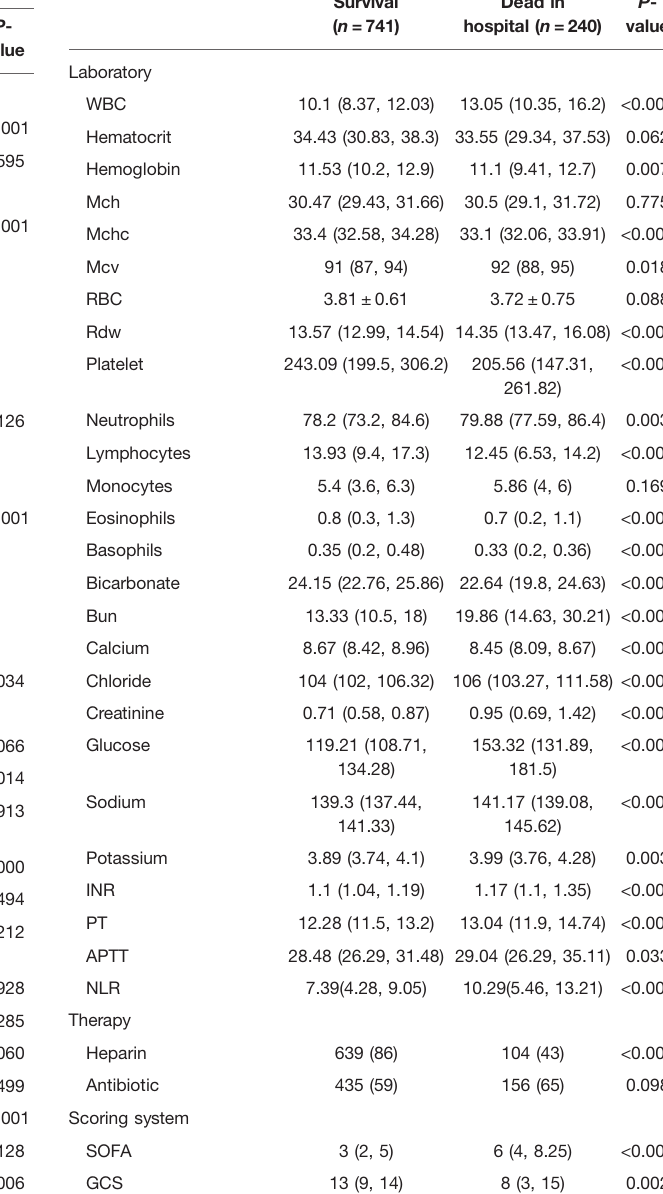
AIDS, acquired immunode fi ciency syndrome; SBP, systolic blood pressure; DBP, diastolic blood pressure; MBP, mean blood pressure; Mch, mean corpuscular hemoglobin; Mchc, mean corpuscular hemoglobin concentration; Mcv, mean corpuscular volume; RBC, red blood cell; Rdw, red blood cell volume distribution width; SPO 2 , oxygen saturation; GCS, Glasgow coma score; SOFA, sepsis-related organ failure assessment; and NLR, neutrophil-to-lymphocyte